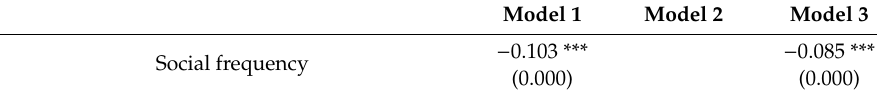
Table 4. Impact of social interaction on public pro-environmental